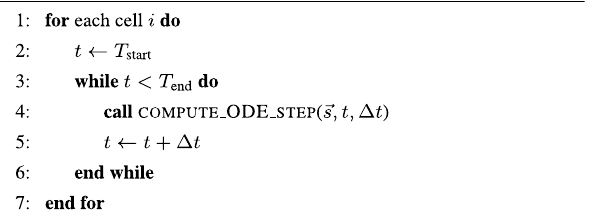
Algorithm 2. Simple skeleton for the ensemble scenario (outer loop over cells).